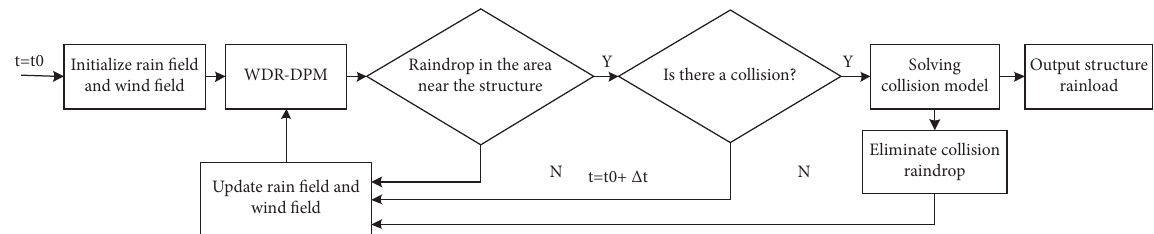
Figure 3: Calculation